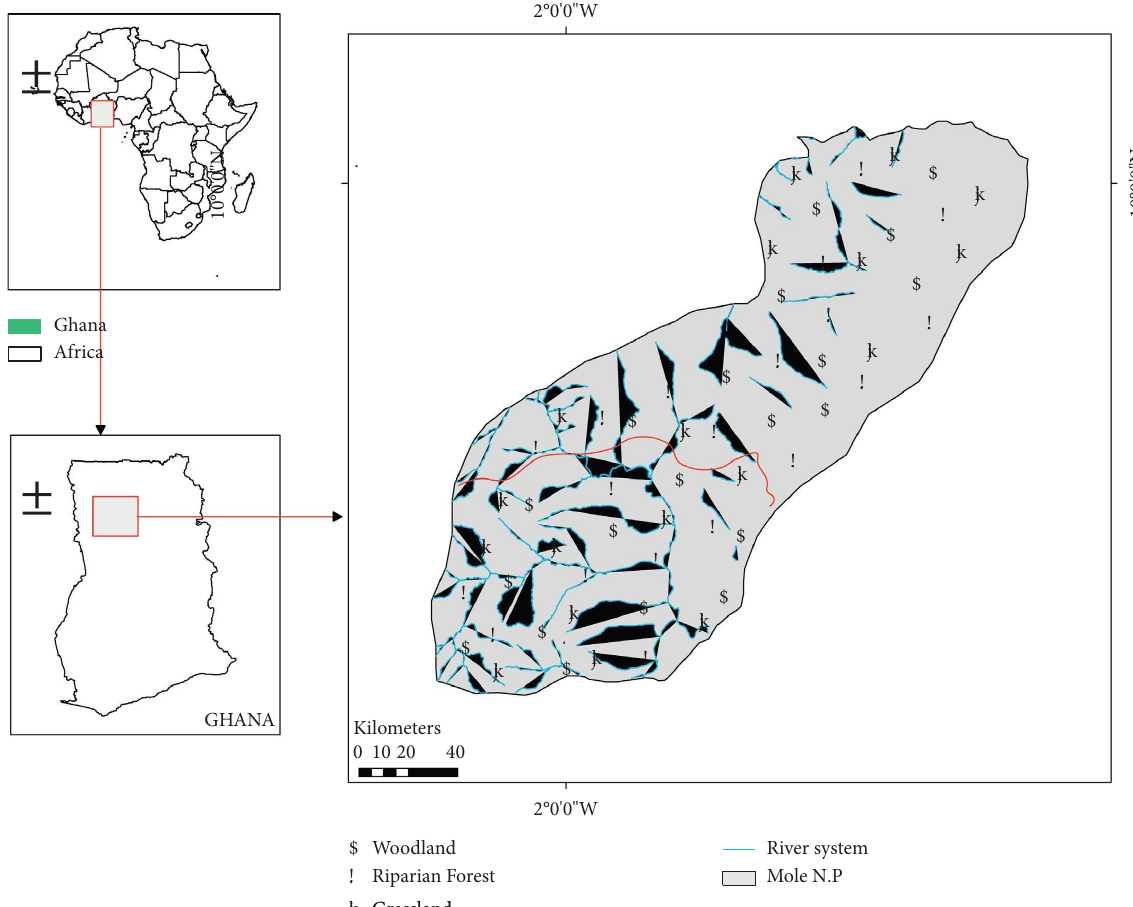
Figure 1: Map of mole national park showing habitats that were surveyed (insert top left is Africa map showing the location of Ghana and down left is Ghana map showing the location of the